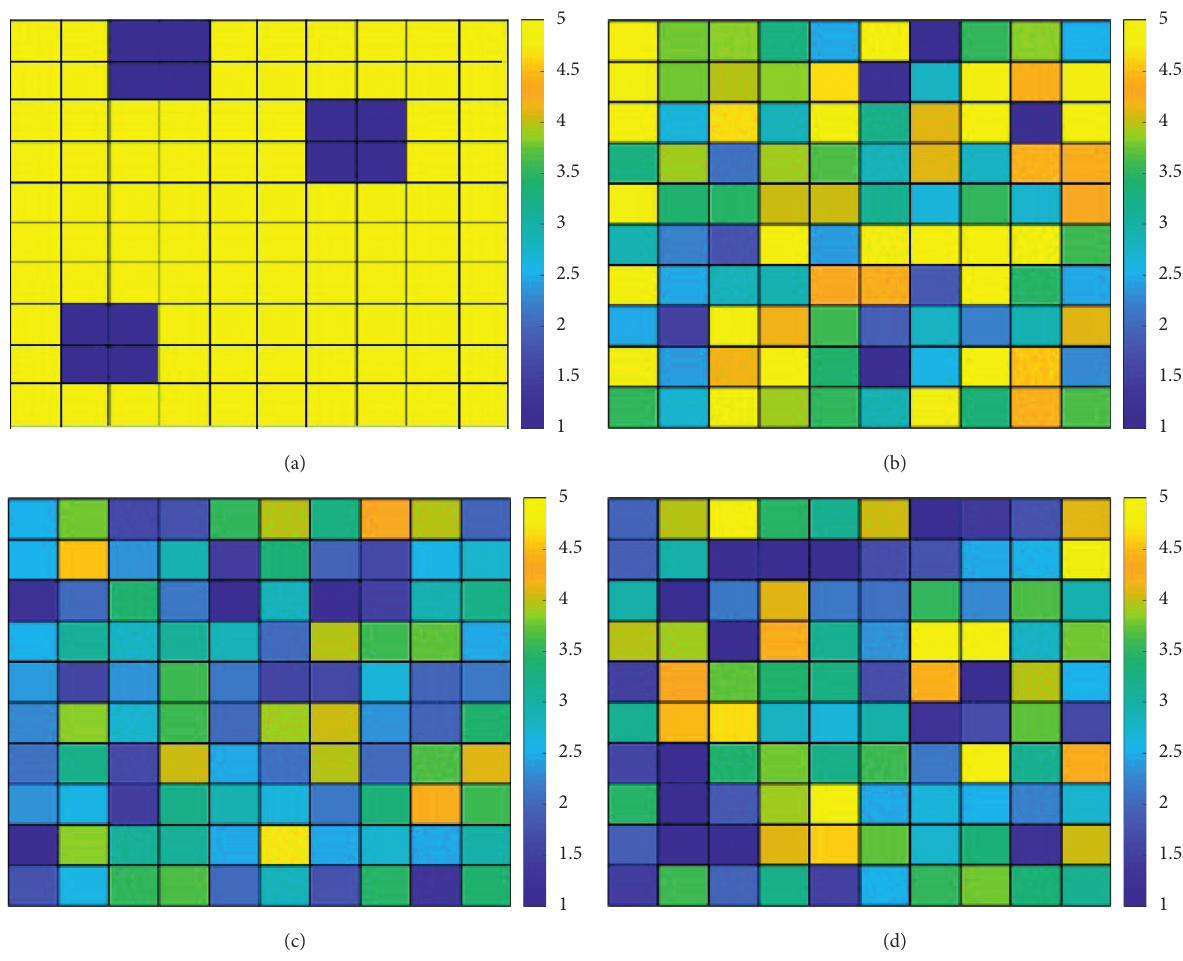
Figure 12: Reconstruction result of the different algorithms. (a) Proposed algorithm. (b) PSO. (c) DE. (d) SCA.